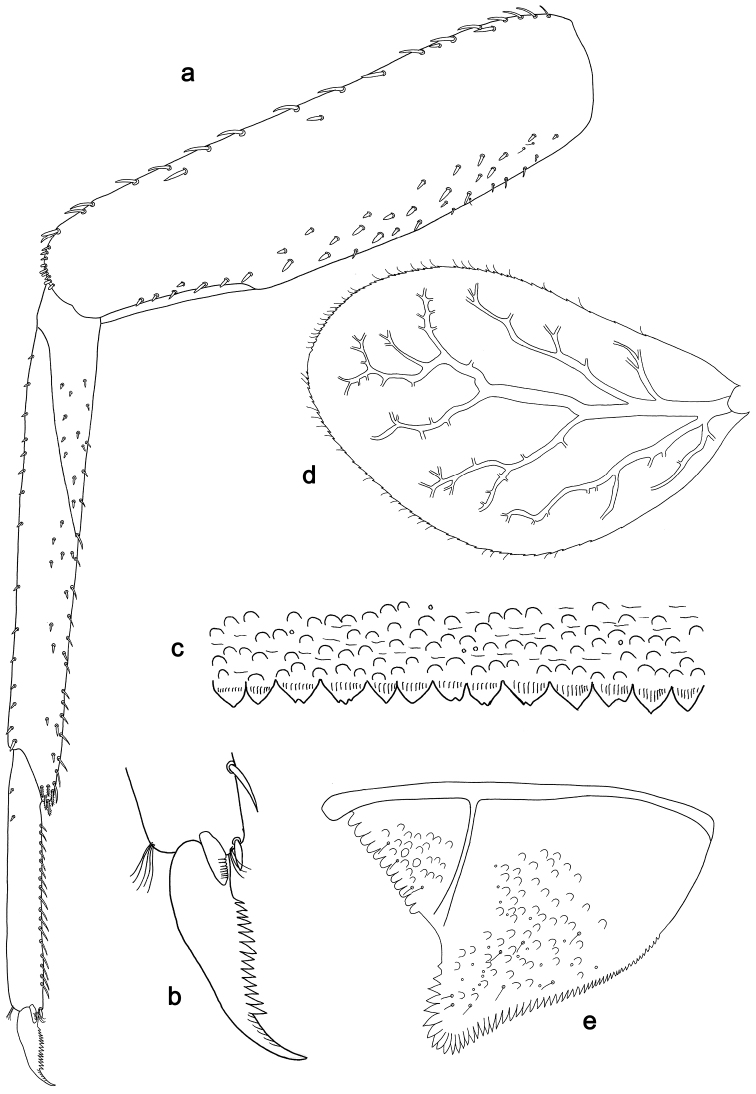
Labiobaetislobatus sp. n., larva morphology: aForelegb Fore claw cTergum IV d Gill IV eParaproct.